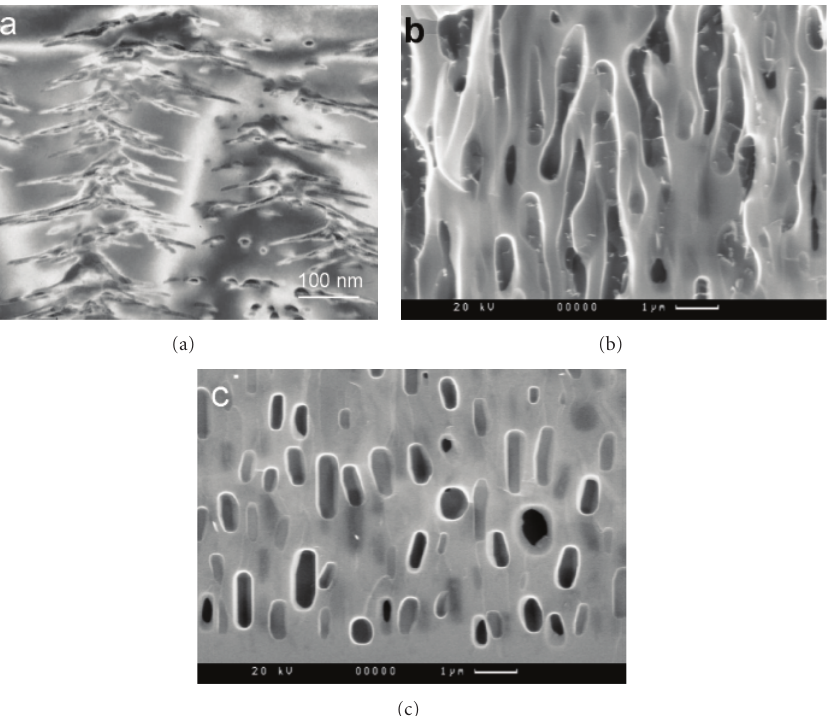
Figure 1: Transmission (a) and scanning ((b) and (c)) electron microscopy images of the cleft edge of porous layer in SiC: straight after anodization (a), after 1700 ◦ C anneal for 120min (b), and after 1700 ◦ C anneal for 240 min (c).